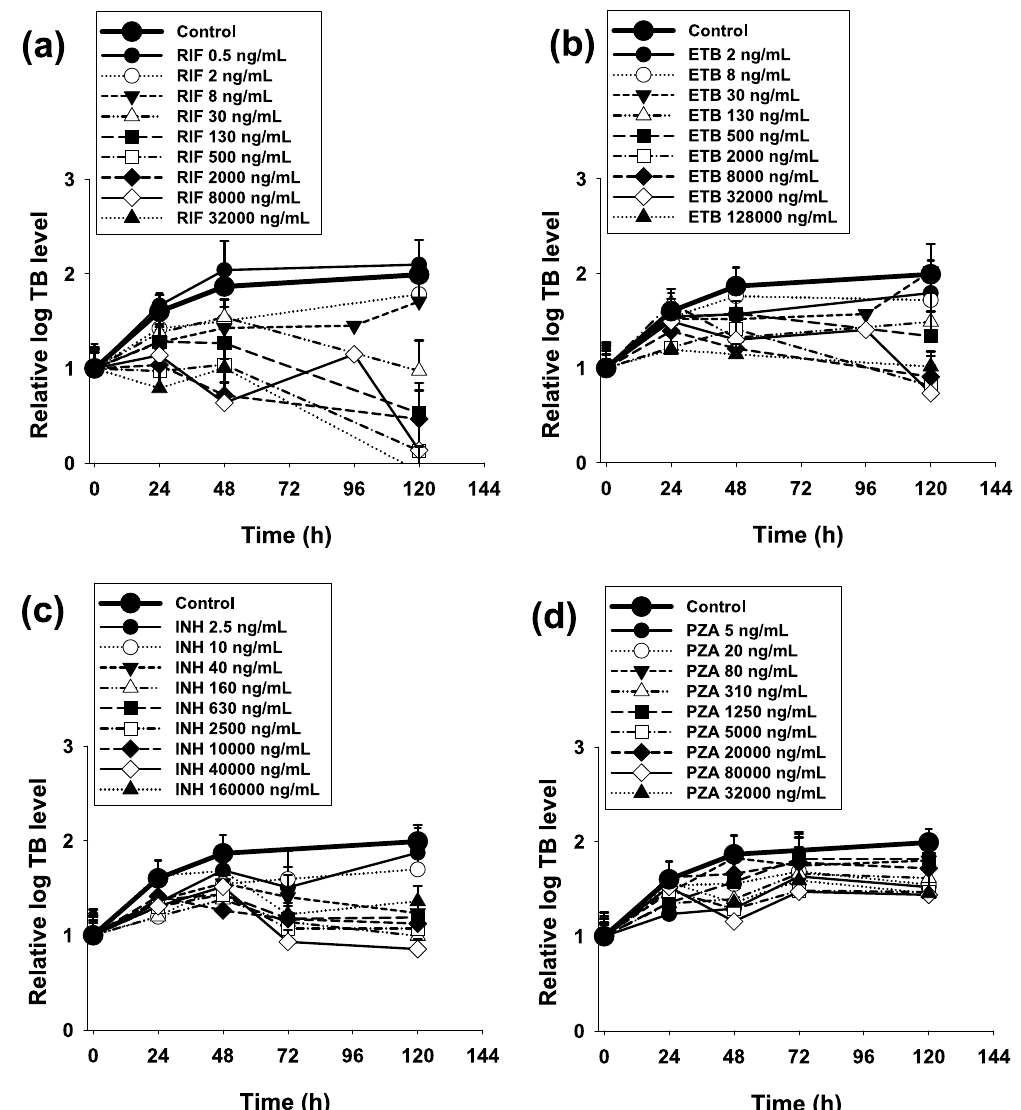
Figure 2. Intracellular (macrophage) M. tuberculosis time-dependent kill. Panels display time-kill profiles of RIF ( a ), ETB ( b ), INH ( c ), and PZA ( d ). Data is mean ± S.D derived from multiple independent experiments ( n ≥ 3) performed in